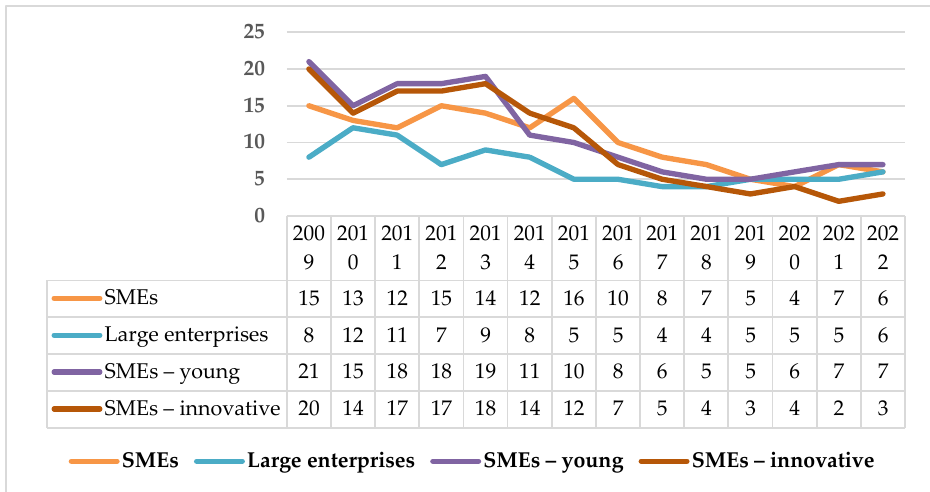
Figure 8. Financially limited firms according to age and size (weighted percentage of surveyed). Source: Adapted from Ref. [77].